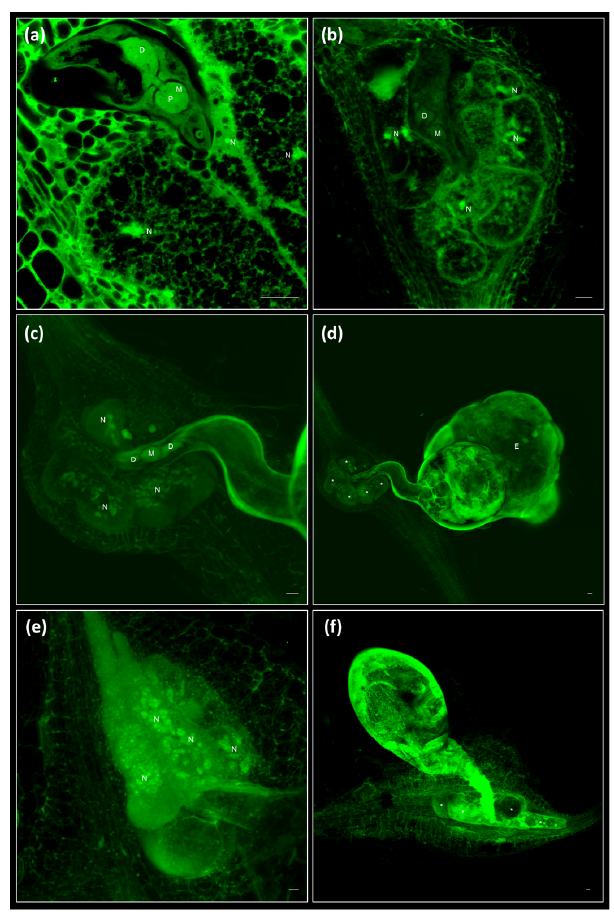
Figure 3. Galls and giant cells, are clearly observed at any stage of development. ( a ) Capture of a gall induced by Meloidogyne javanica in Arabidopsis thaliana roots at 14 dpi completely sectioned in Video S3. ( b ) Image derived from the Z-Stack (Sum) of 97 images from a gall at 14 dpi ( c , d ). Image derived from Z-Stack (Std) of 229 ( c ) or 49 ( d ) images from a gall at 60 dpi completely sectioned in Video S5. ( e , f ) Pictures at different magnification of giant cells induced by Meloidogyne javanica in cucumber roots at 45–60 dpi. Scale bars: 20 μ m. The images were taken from entire galls after fixation with glutaraldehyde and clearing with BABB. Asterisks (*): giant cells. D: dorsal gland; E: egg mass; M: metocorpus; N: nucleus; P: pump